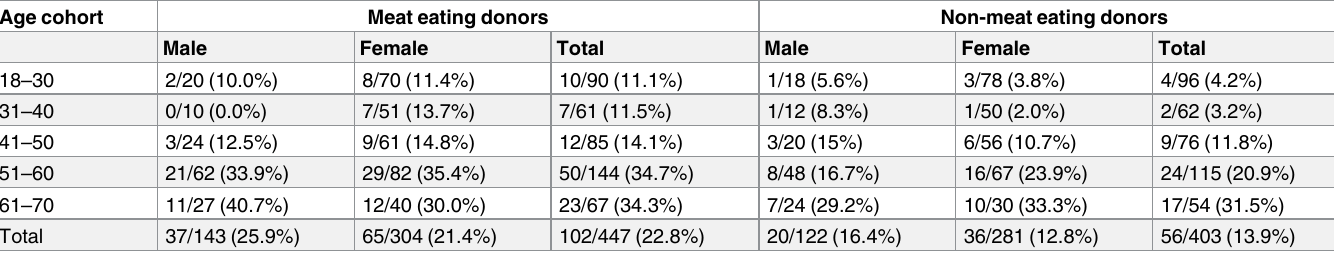
Table 1. Anti-HEV IgG prevalenceamong Dutch donors who do not eat meat and those who eat meat on a daily basis. Age cohort Meat eating donors Non-meat eating